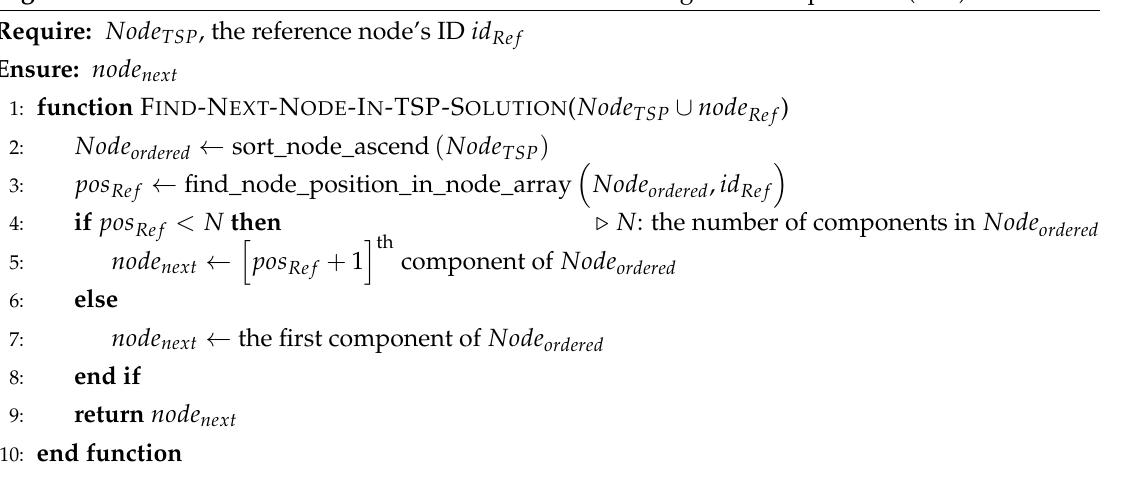
Algorithm 6 Next node selection in the solution to the traveling salesman problem